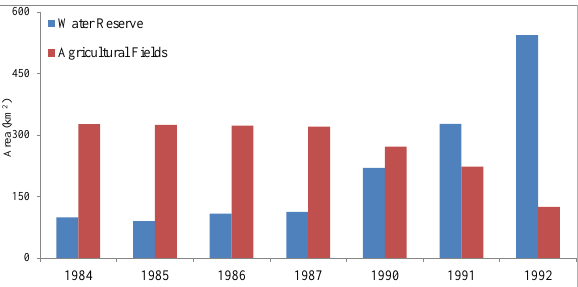
Fig. 3 Spatial variations of agricultural fields and water reserve.